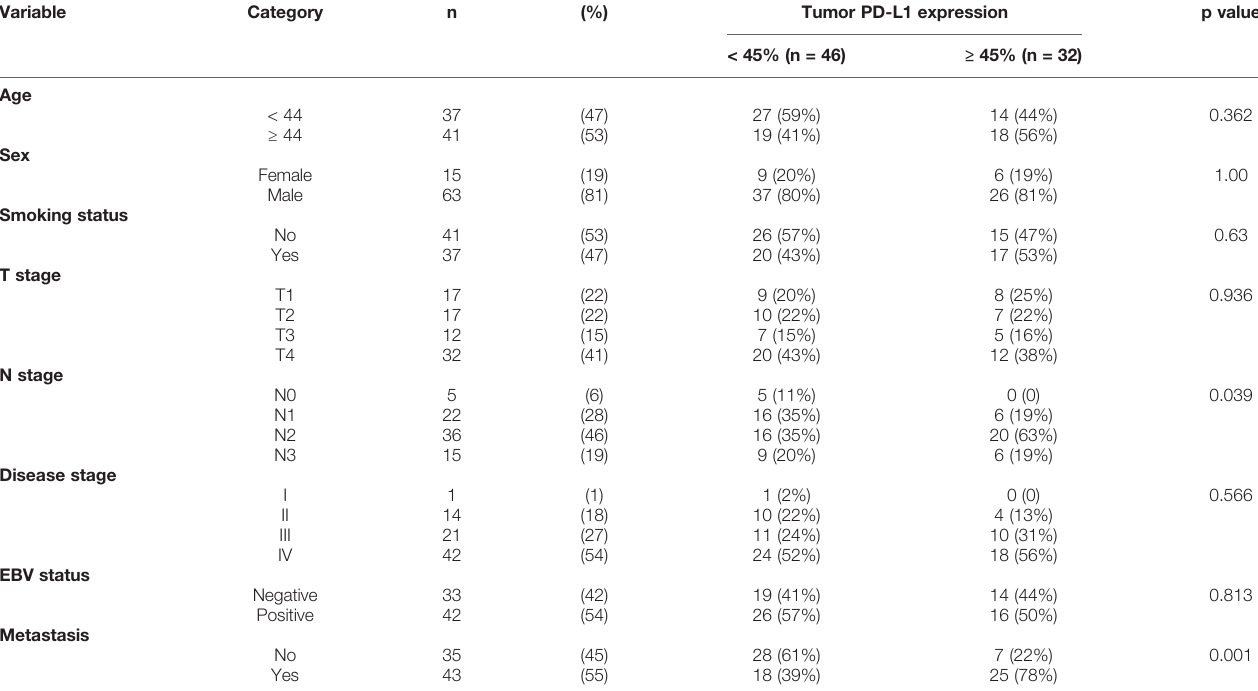
TABLE 1 | Association between PD-L1 expression and clinicopathological features of patients with NPC.